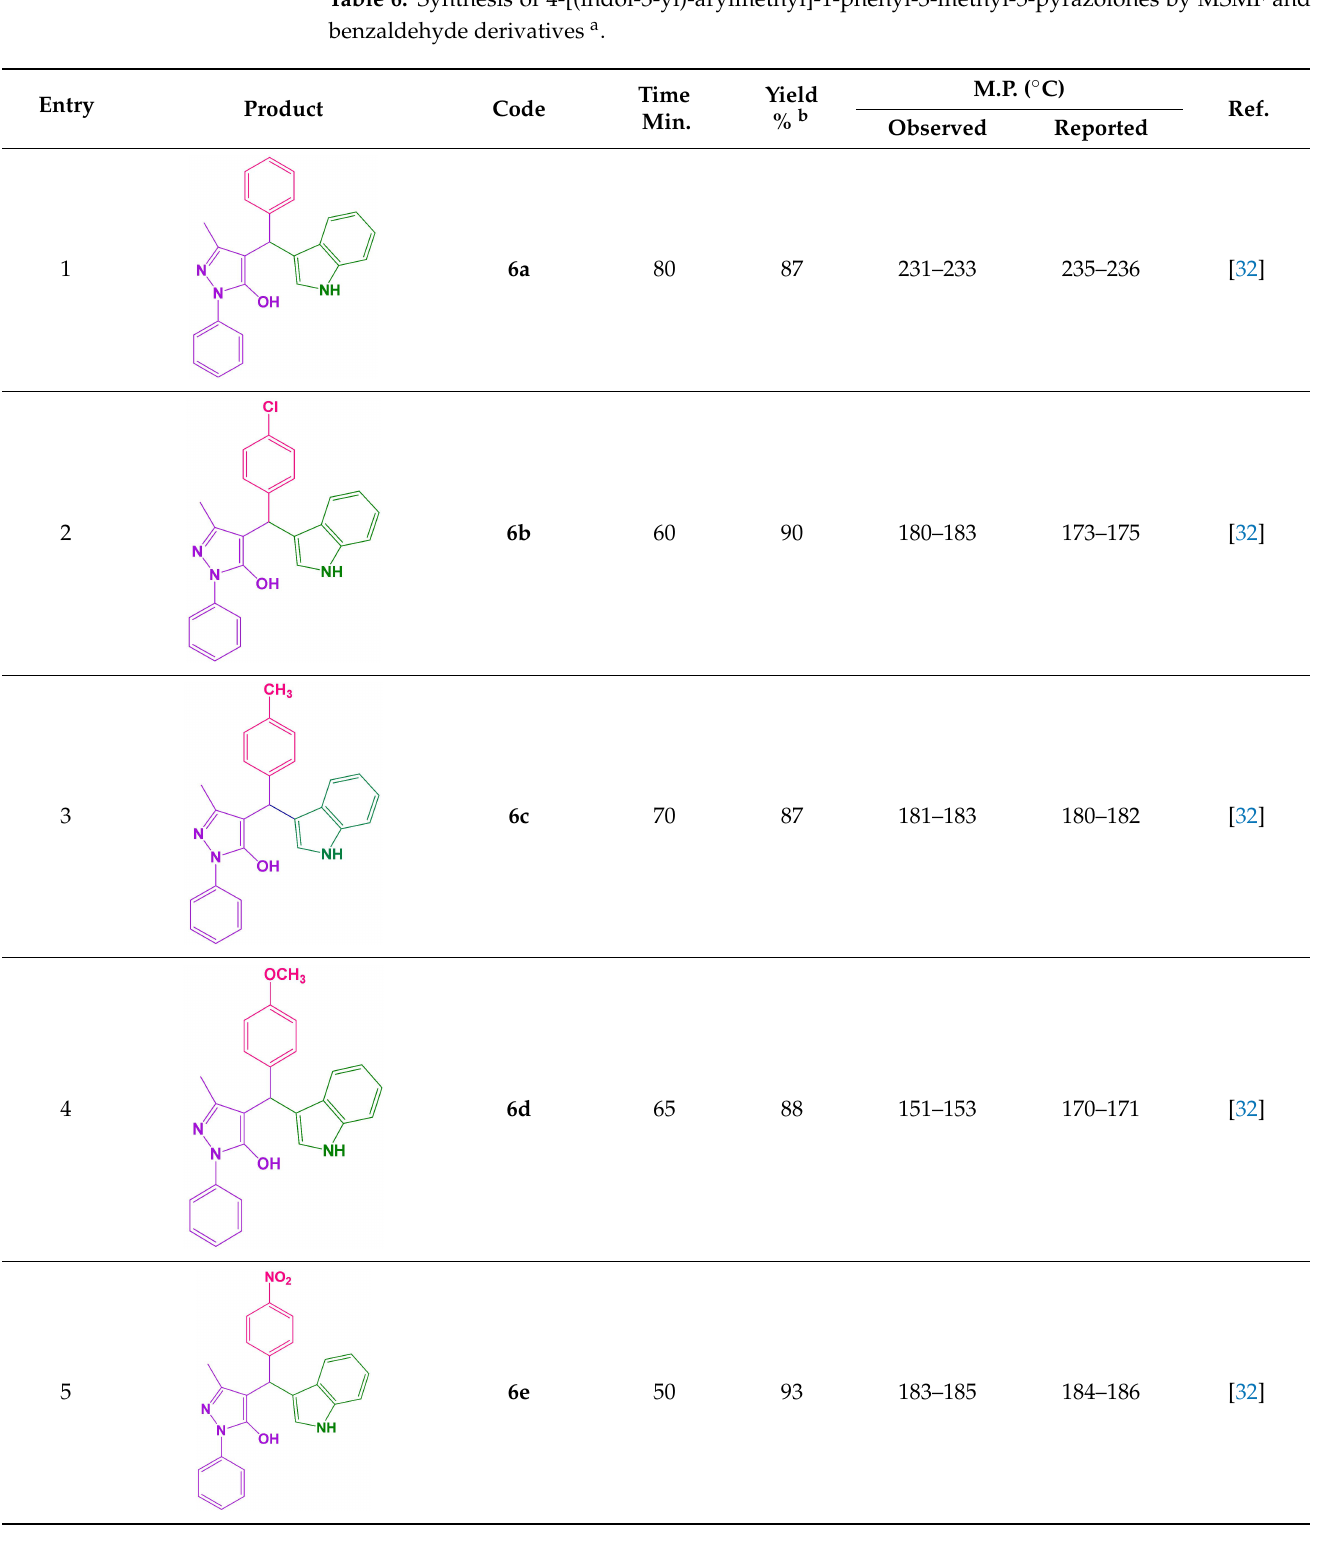
Table 6. Synthesis of 4-[(indol-3-yl)-arylmethyl]-1-phenyl-3-methyl-5-pyrazolones by MSMF and benzaldehyde derivatives a